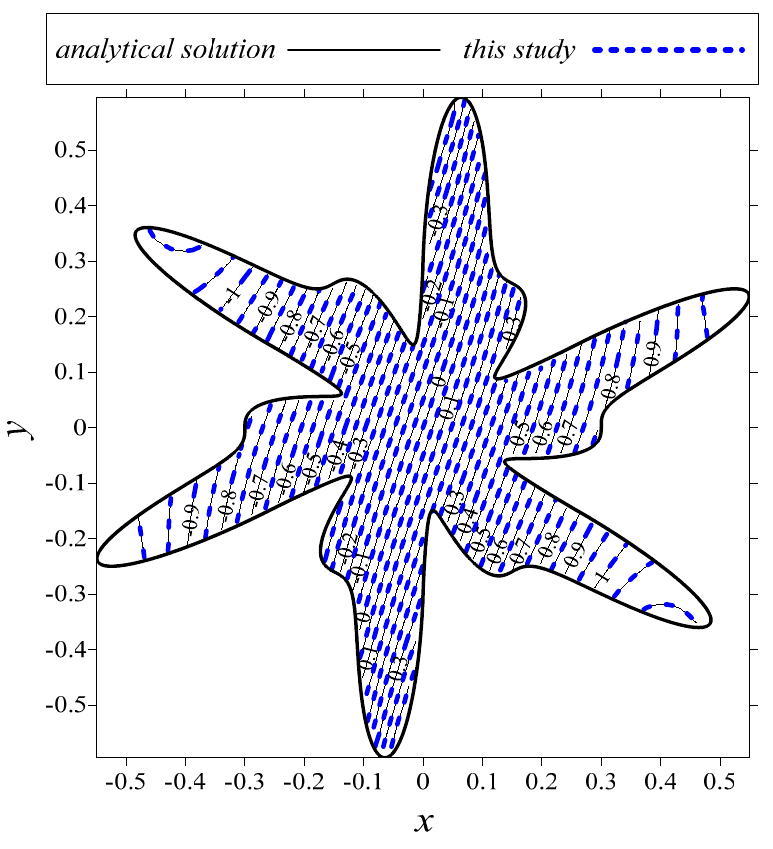
Figure 5. Comparison of the numerical solution with the analytical solution.